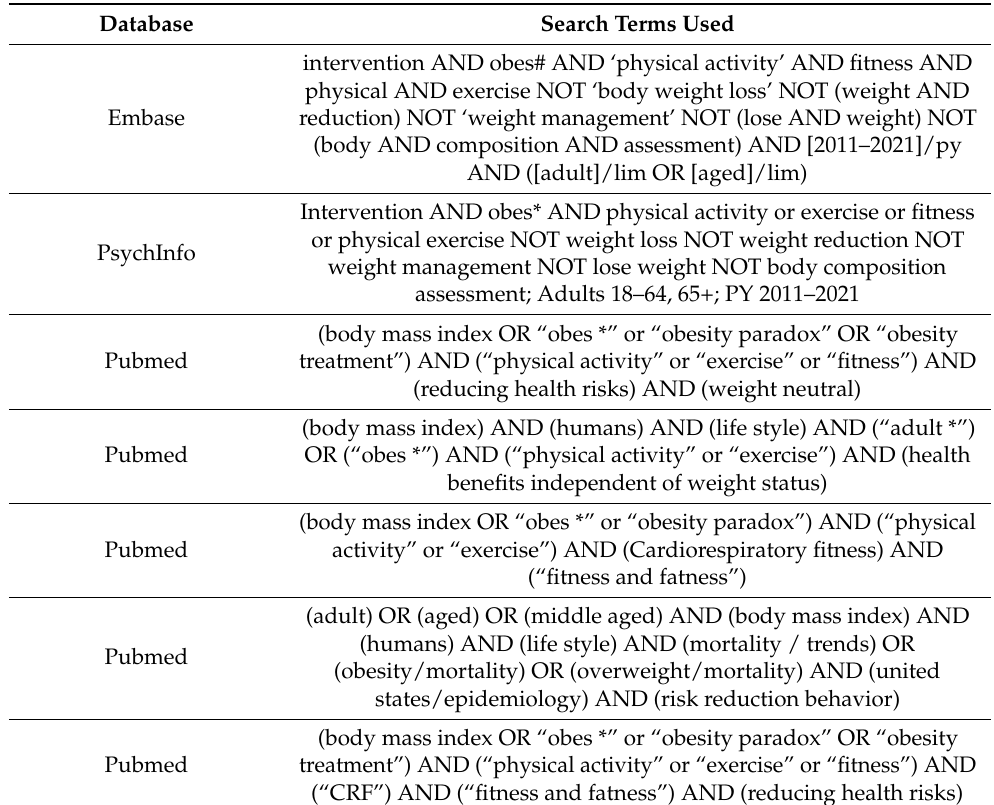
Table 1. All search